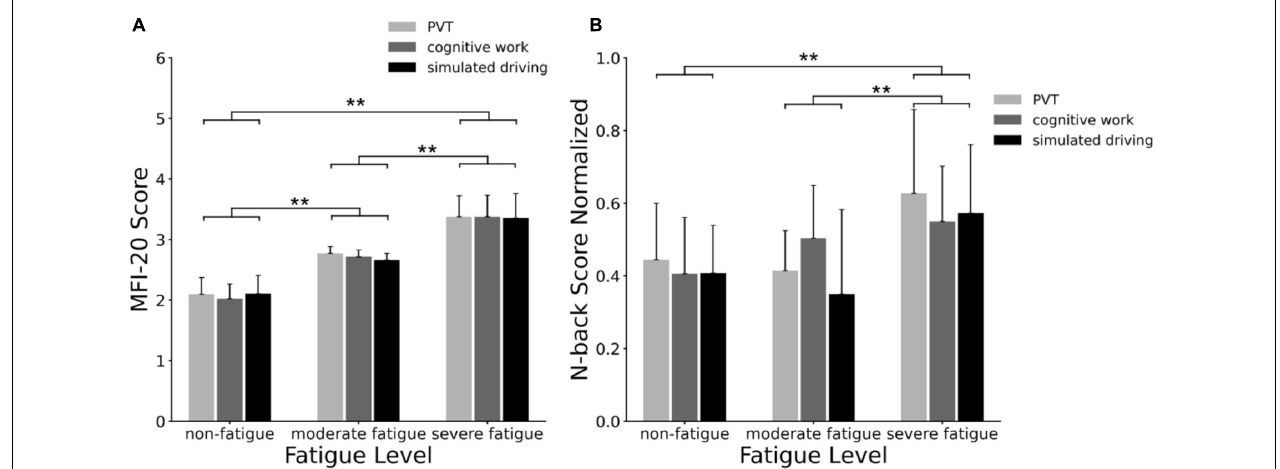
FIGURE 4 | (A) Multidimensional Fatigue Inventory (MFI-20) scale scores correspond to non-fatigue, moderate fatigue, and severe fatigue grade participants; the mean and standard deviation of each group were calculated; (B) behavioral task performance corresponded to non-fatigue, moderate fatigue, and severe fatigue participants. The behavioral task scores (reaction time/accuracy) were normalized, and the mean value and standard deviation of each group were calculated. ** p < 0.01.